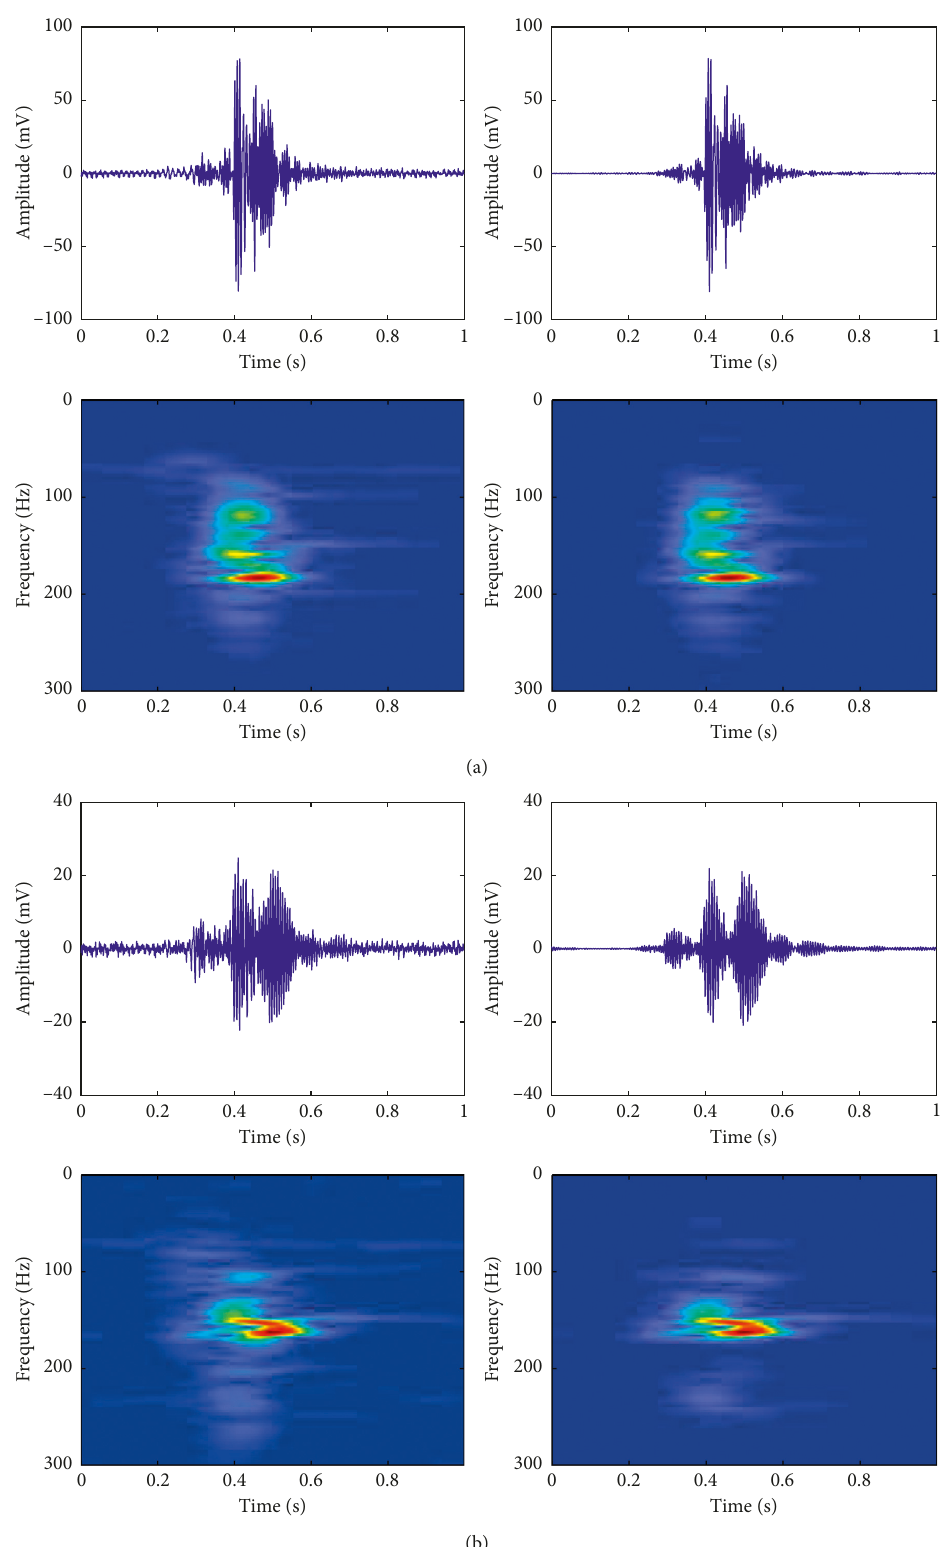
Figure 9: Validation of typical signals: (a) denoising before (left) and after (right) signal 3#; (b) denoising before (left) and after (right) signal